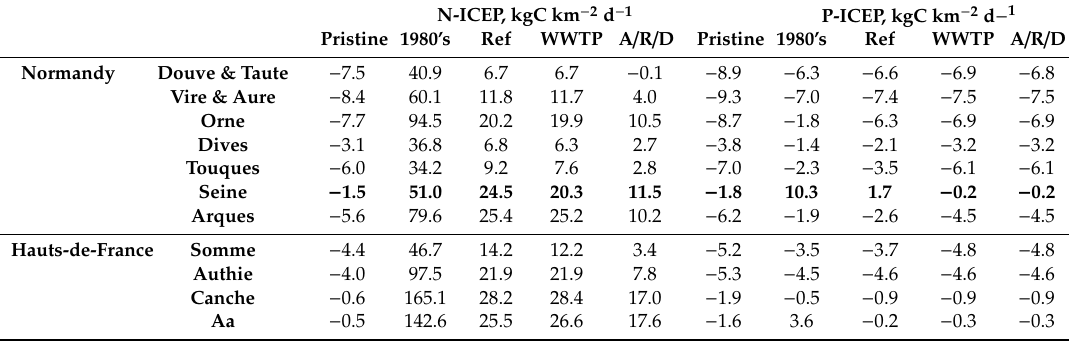
Table 7. Indicator of coastal eutrophication potential for N and P (N-ICEP and P-ICEP) for the rivers studied and averaged for 2002–2014 (reference period; Ref) and calculated for four scenarios (see text).